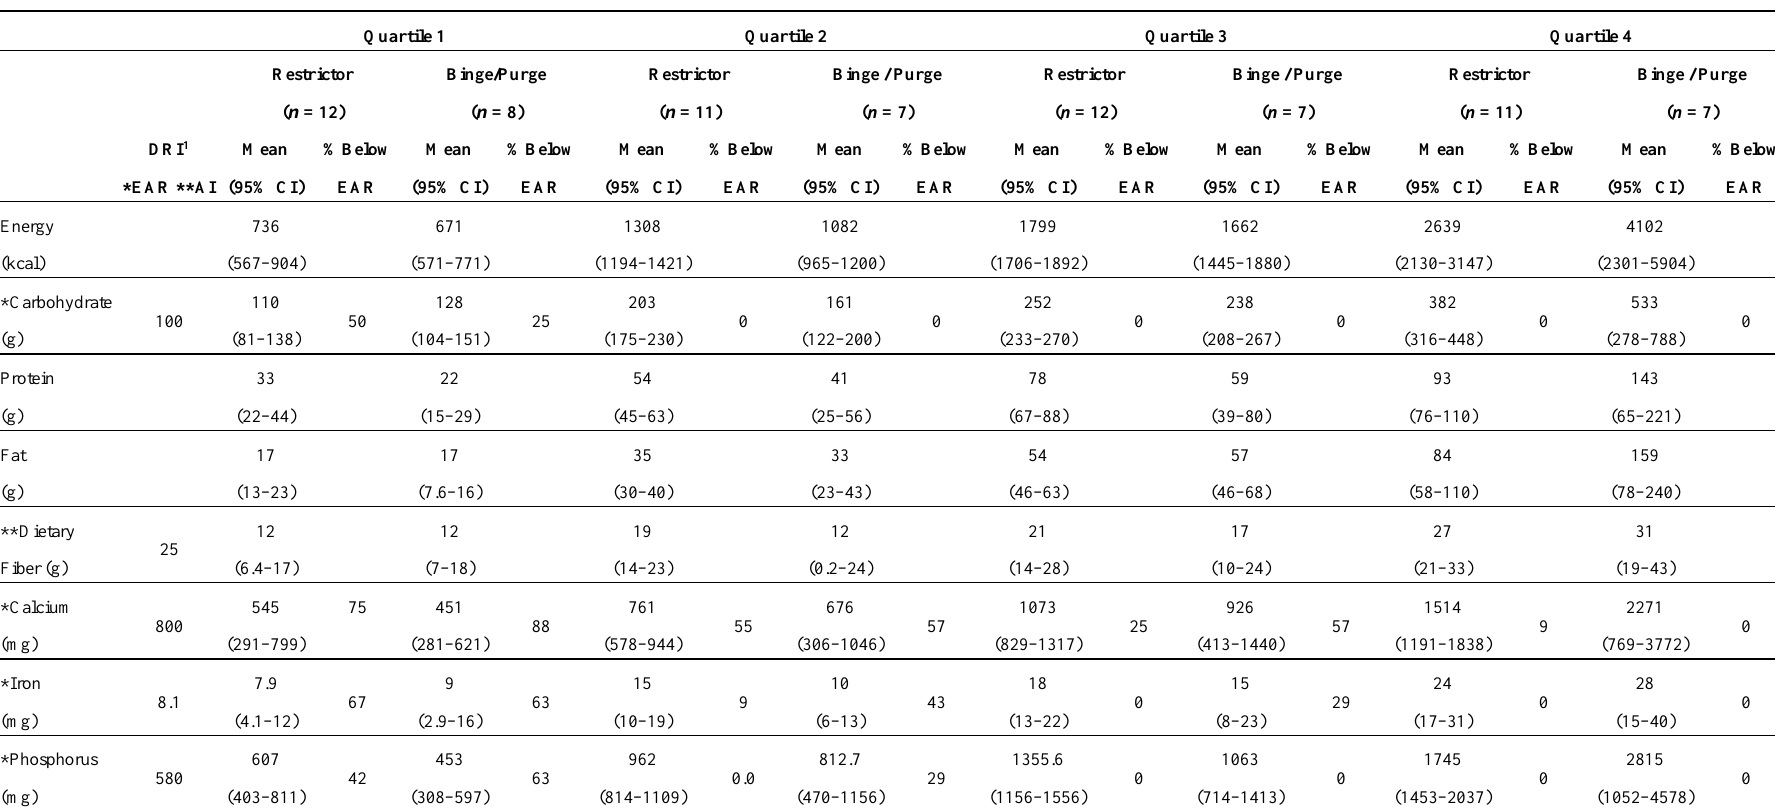
Table 1. Reported dietary intake of individuals with anorexia nervosa (by subtype and quartile) and percent not meeting the Dietary Reference Intakes